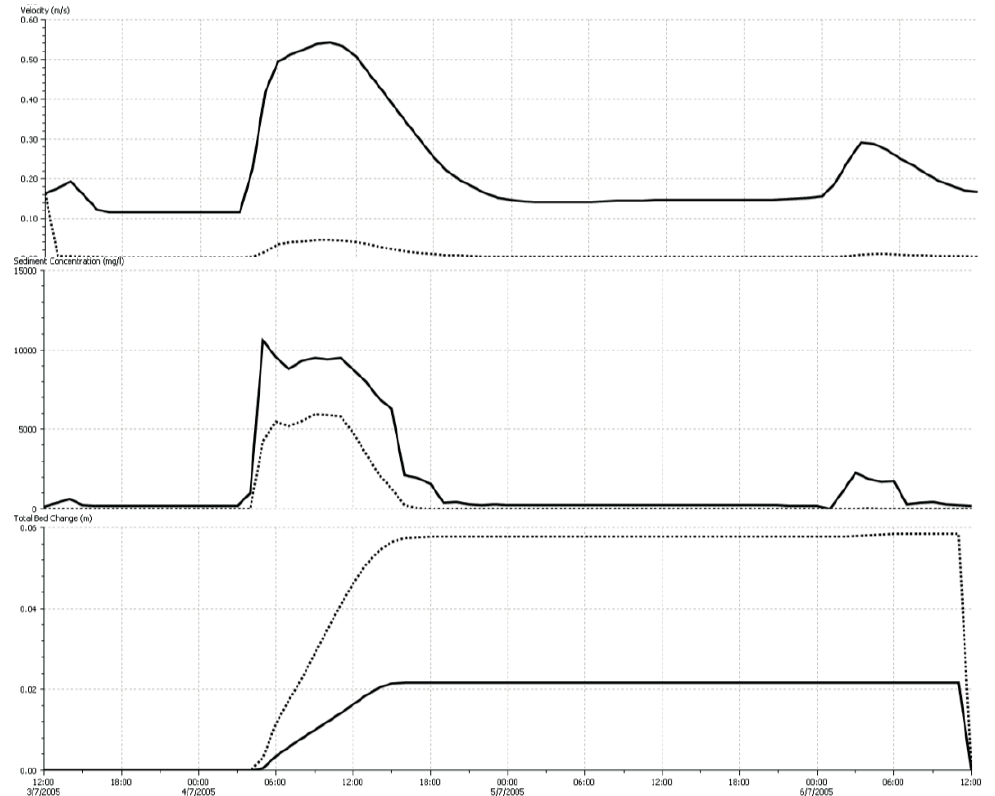
Fig. 4 Flow velocity, SSC and deposition on the Maarkebeek (downstream) during the event of 04/07/2005, without (solid line) and with upstream sediment trap (dotted